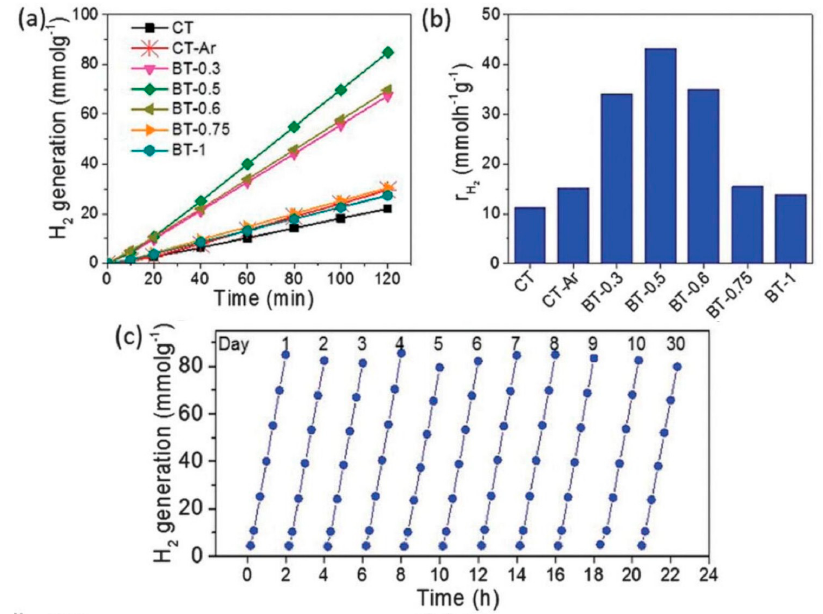
Figure 10. ( a ) H 2 generation profile, ( b ) rate (rH 2 ) of hydrogen generation for different samples, and ( c ) the stability study of the sample BT-0.5 under the full solar wavelength range of light [70]. Copyright 2015 The Royal Society of Chemistry.